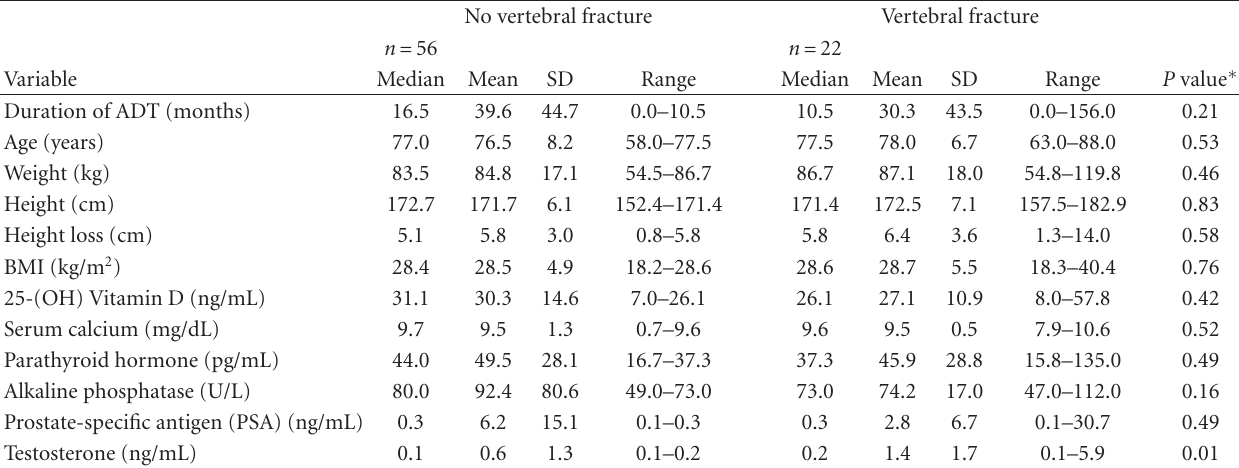
Table 1: Baseline characteristics stratified by presence of vertebral fracture.